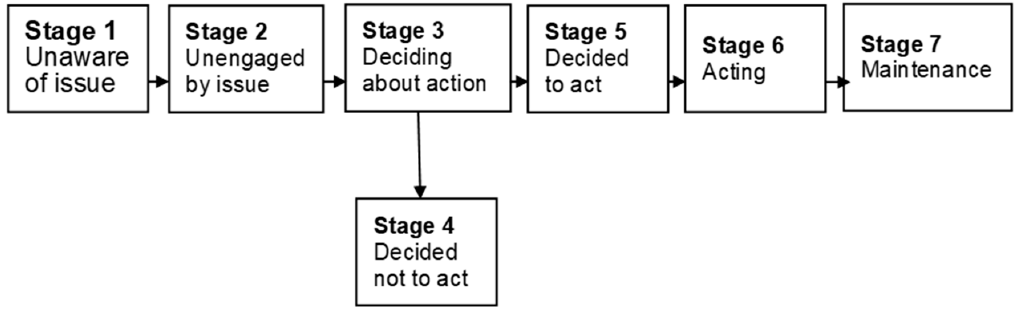
Figure 1. Stages of the Precaution Adoption Process Model. Note: Sourced from Weinstein, Sandman, and Blalock (2008).